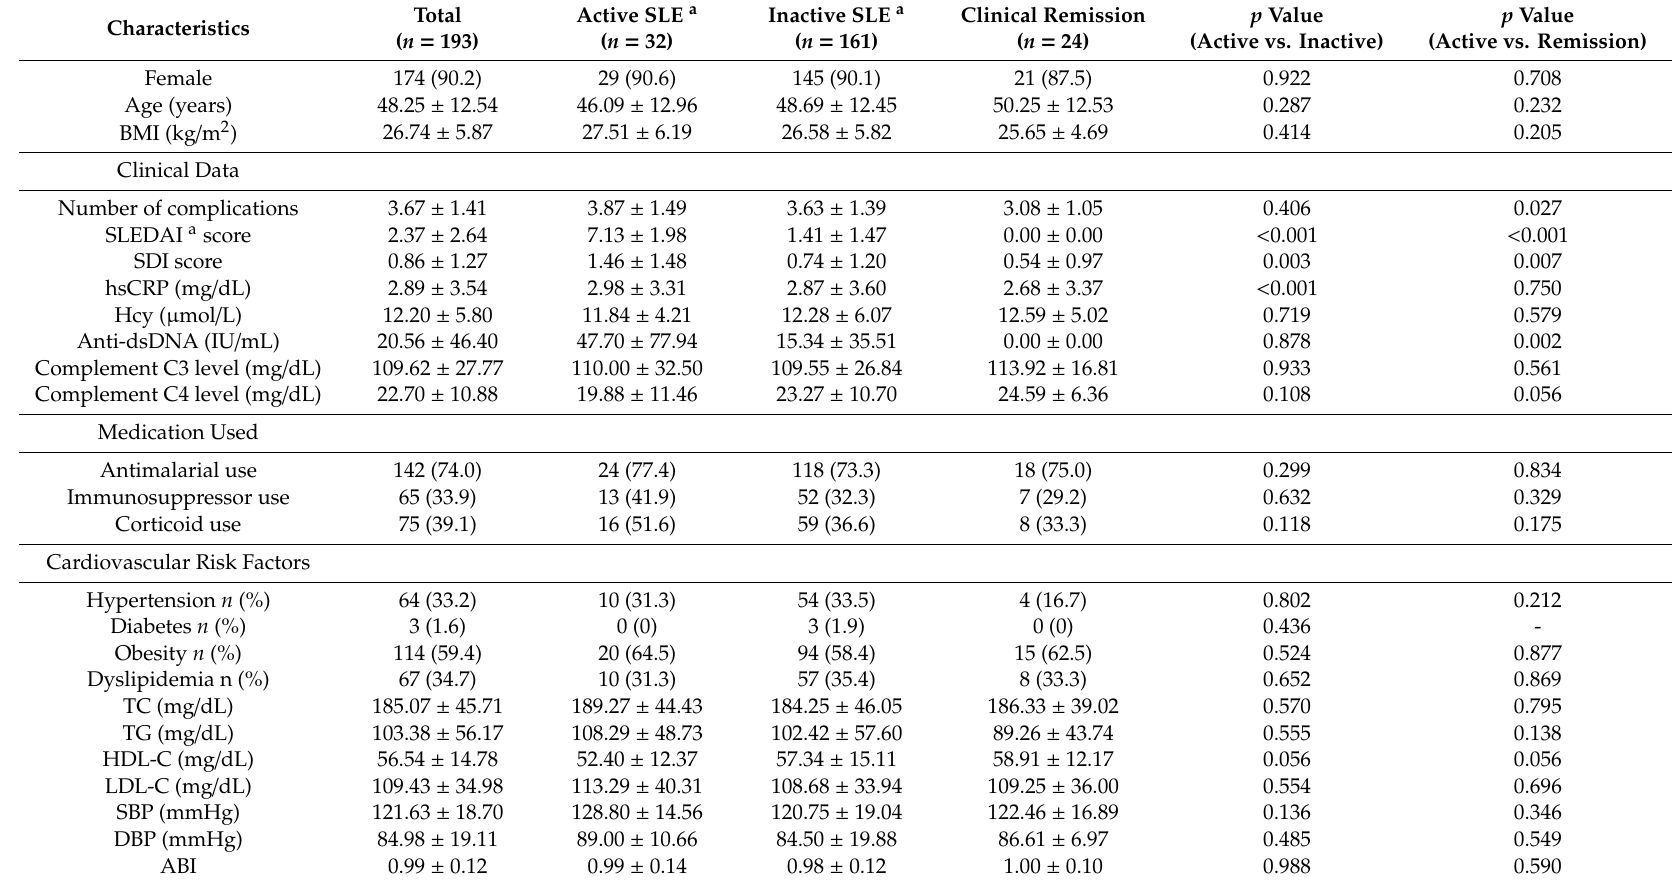
Table 1. Descriptive of the main characteristics of the study population classified as, active / inactive systemic lupus erythematosus (SLE) and clinical remission.